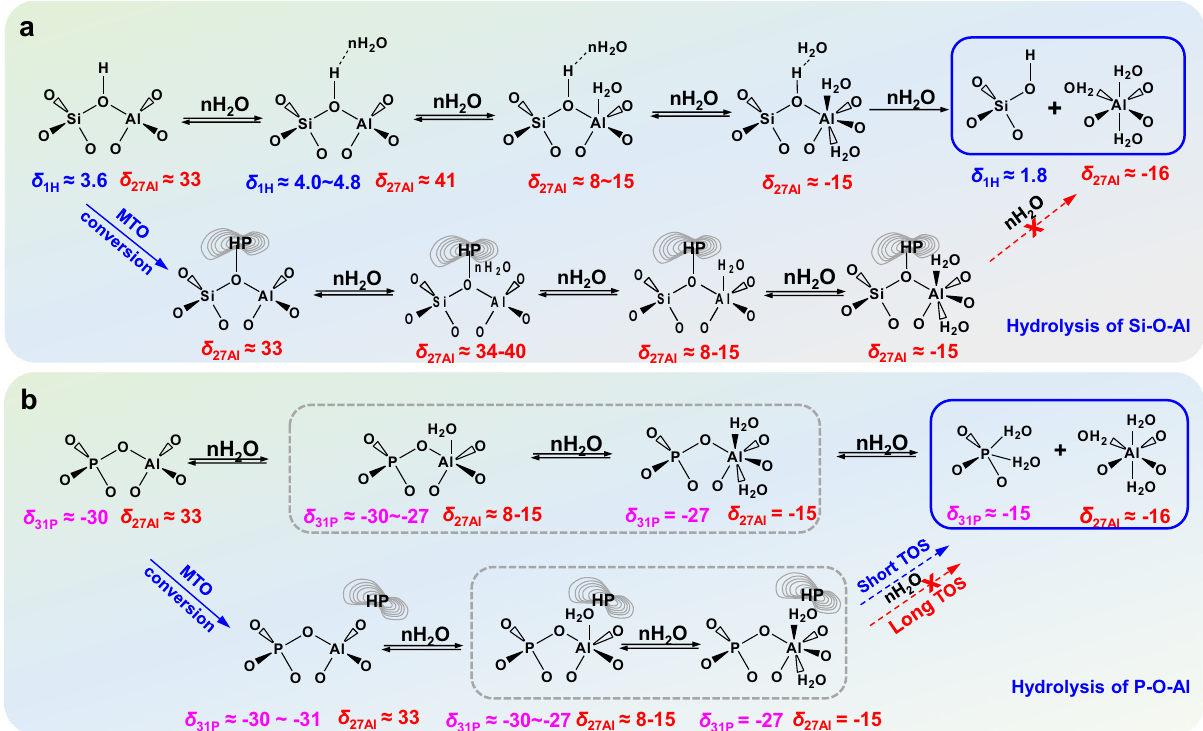
Fig. 4 Proposed hydrolysis process of T-O-T bonds. Schematic illustration of the hydrolysis process of framework Si-O-Al ( a ) and P-O-Al ( b ) bonds for fresh and spent SAPO-34 catalysts after the MTO